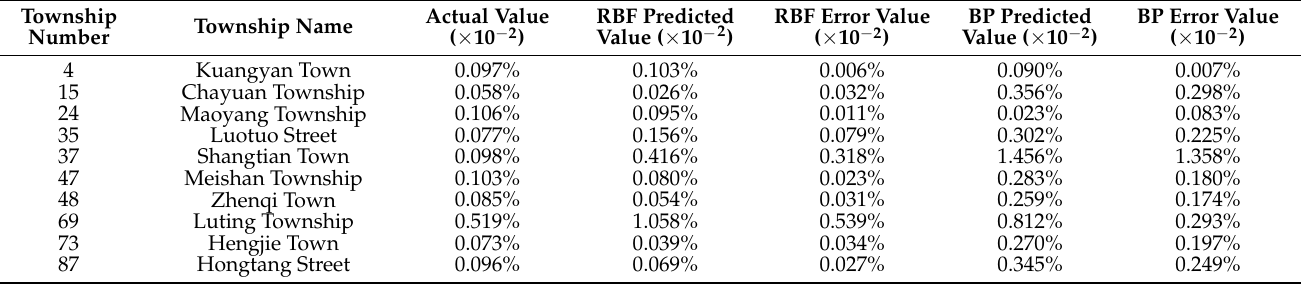
Table 3. Average insured loss rates in 2019 for rural housing in the most severely affected